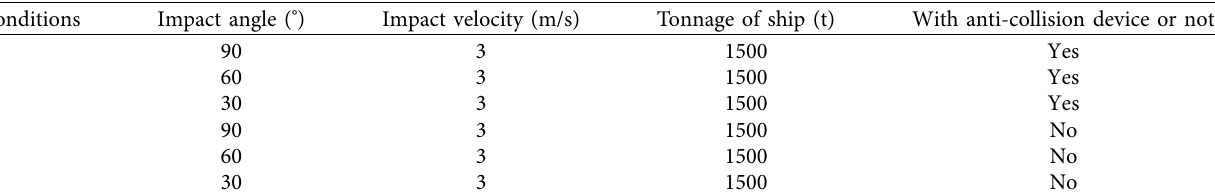
Table 2: Impact scenarios at different angles.